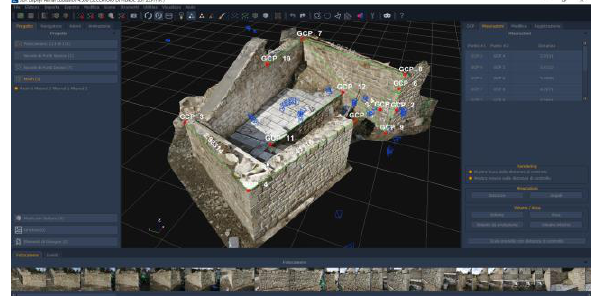
Figure 10. The model of the relief of the new building processed with the 3DF Zephyr®.